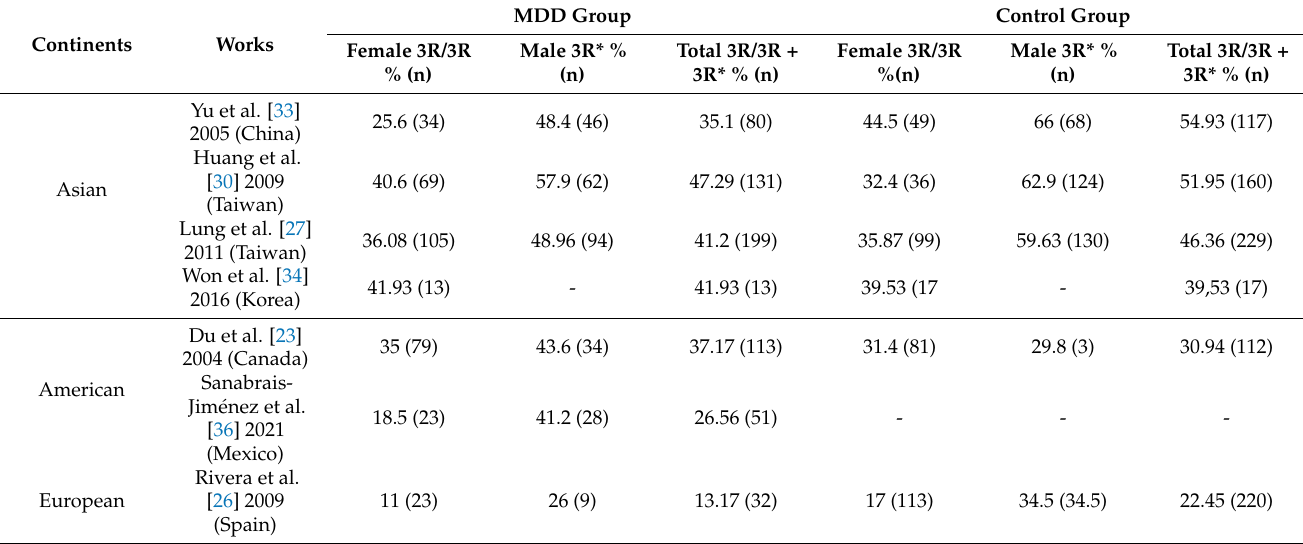
Table 2. Comparison between MAOA uVNTR variant’s 3R/3R (female homozygote) and 3R* (male hemizygote) genotype frequencies @ in patients with Major Depression Disorder (MDD) and healthy controls in the studies reviewed per